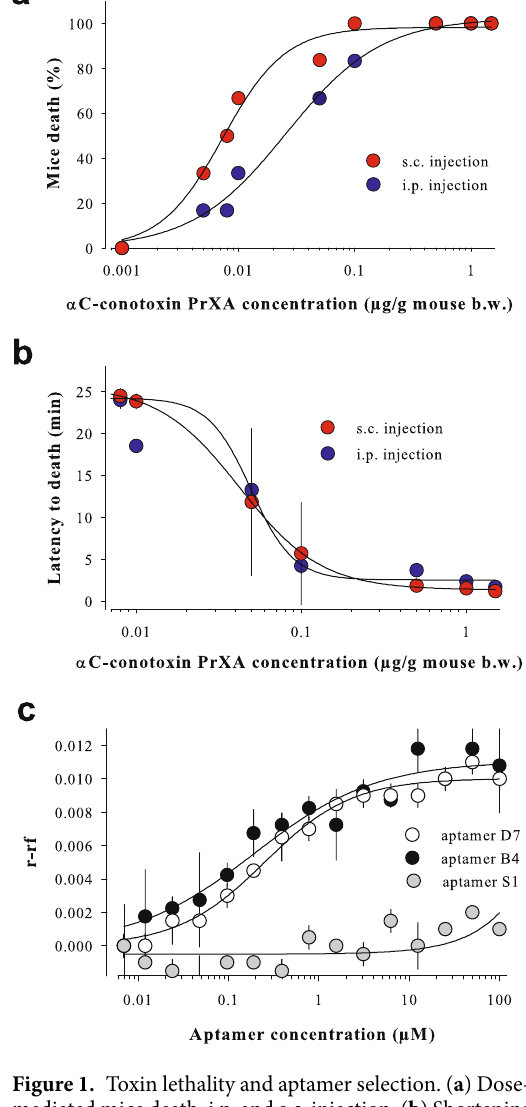
of muscle contraction with full block occurring after 15 min with the highest toxin concentration used (Fig. 2d and left inset). The inhibition of contraction is the result of postsynaptic nAChR block and not a direct effect on the contraction machinery since direct electrical stimulation of the hemidiaphragm muscle did not alter muscle contractility force (Fig. 2d and right inset). The α C-conotoxin PrXA inhibited nerve-evoked muscle contrac- tions with an IC 50 of 23 ± 2 nM (Fig. 2e). Consistent with its effects on α C-conotoxin PrXA-mediated inhibition of [ 125 I]- α -BgTx binding, 1.2 µ M D7 aptamer produced complete block of contraction inhibition (Fig. 2f). In contrast, the B4 aptamer had no effect at 2.5x higher concentration (Fig. 2f). For complete assessment of selec- tivity, a venom snake nicotinic toxin blocker, waglerin 1 33 , was synthesized and tested for its inhibition of muscle contraction (Fig. 2g). Waglerin 1 produced full block of contraction with an IC 50 = 58 ± 2 nM, which is twofold less potent as α C-conotoxin PrXA. As shown in Fig. 2h, the D7 aptamer did not affect the waglerin 1 activity, indicating its specificity towards α C-conotoxin PrXA.